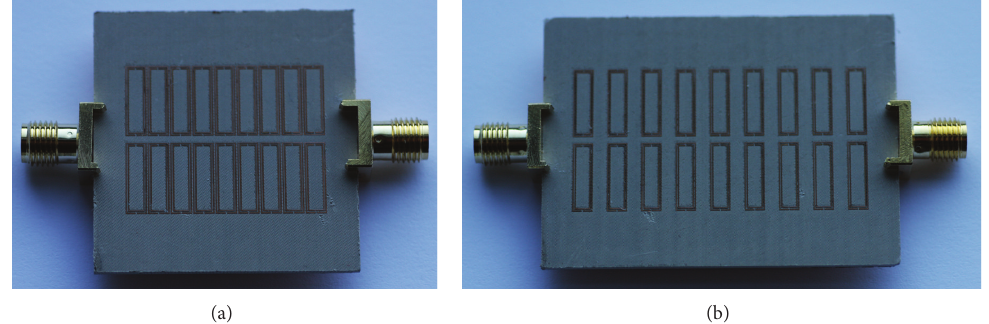
Figure 7: Photograph of the bottom face of the fabricated order-9 structures composed of the unit cell in Figure 4 with (a) 𝑙 = 3 mm and (b) 𝑙 = 4.8 mm. From [34], reprinted with permission.